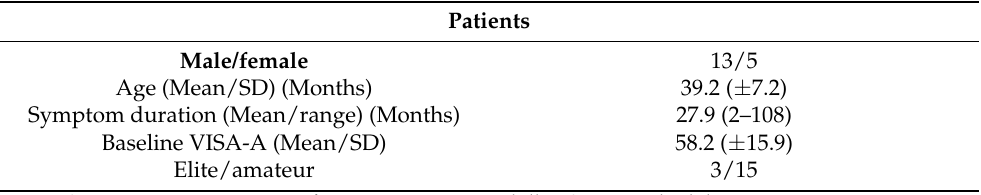
Table 1. Demographics of patients.